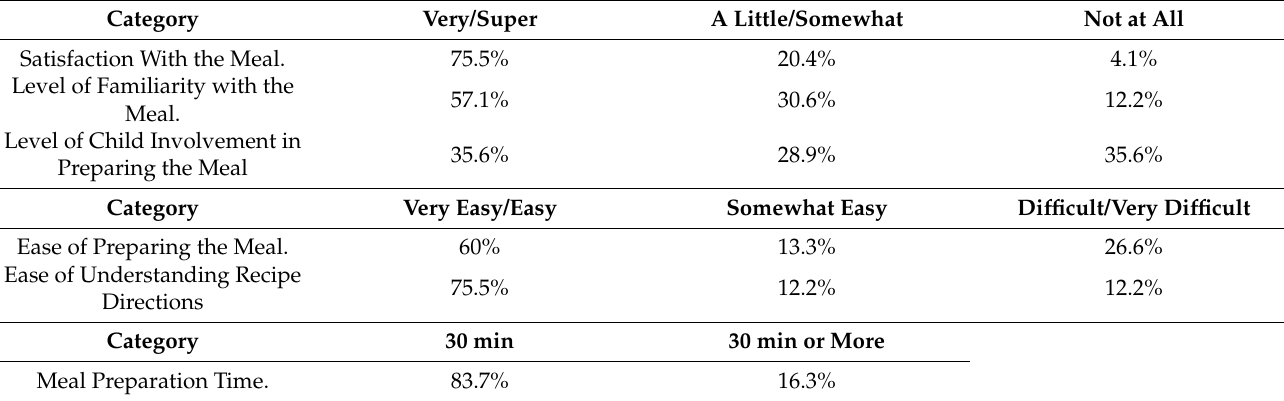
Table 3. Summary of Weekly Feedback Survey